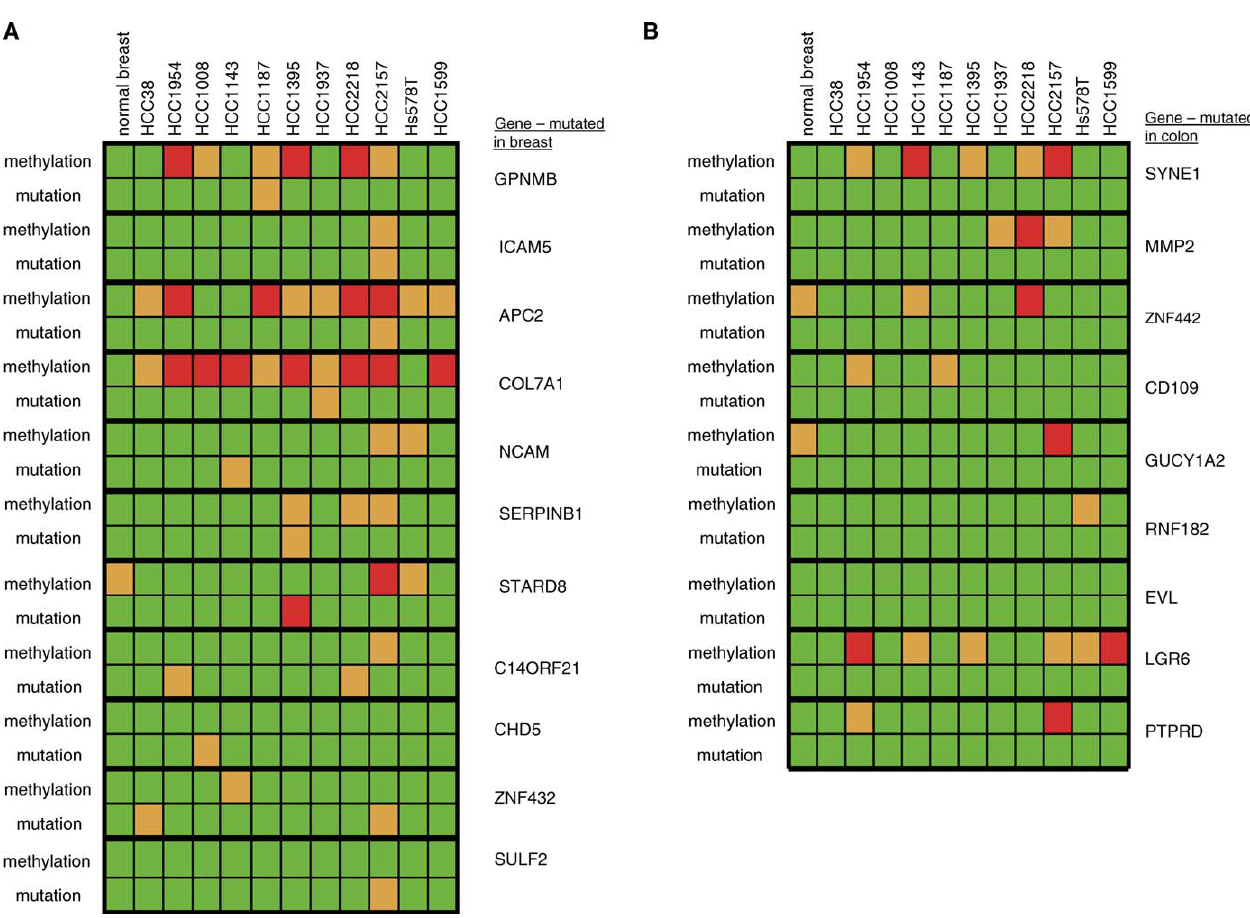
Figure 7. Concomitant Mapping of Mutation and Methylation of CAN Genes in Human Breast and Colon Cancers (A) Results for breast CAN genes. Gene names are listed at the right of the map. For each gene, the methylation and mutational status is shown for the 11 breast cell lines that were subject to large-scale sequencing described by Sjoblom et al. [7] and normal breast tissue. Green indicates no methylation or mutation detected. Red indicates complete methylation or homozygous mutation. Orange denotes heterozygous mutation or partial methylation. (B) Results for colon CAN genes. Data are presented in the same format as in (A).